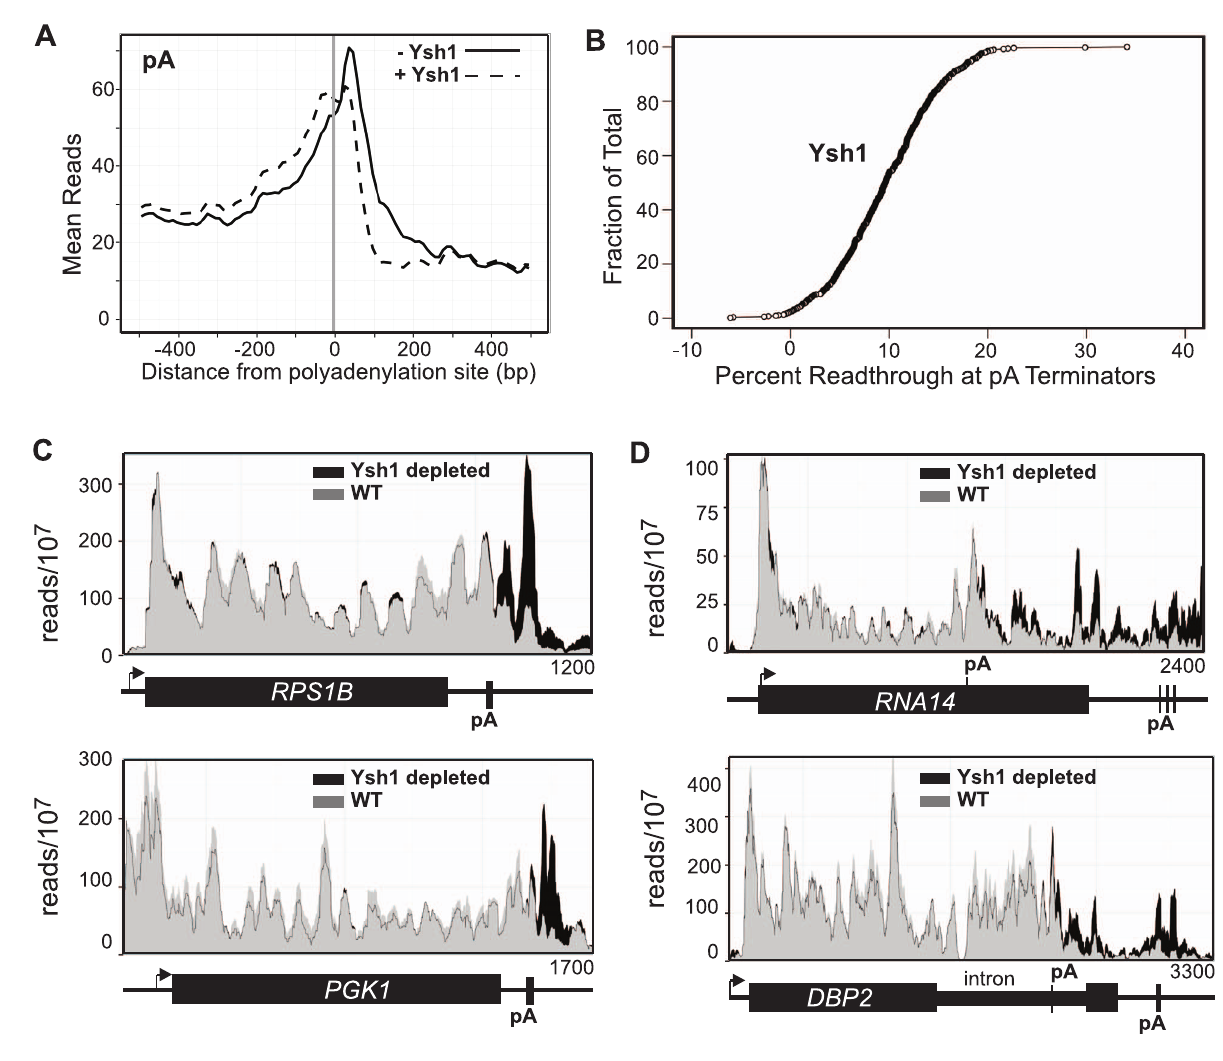
Figure 2. Ysh1 depletion causes readthrough at pA sites. A. Mean reads every 10 bp for the 500 most frequently used pA sites with (dotted) and without (solid) Ysh1. B. Plot showing percent readthrough of each of 500 pA terminators as a fraction of the total 500 pA terminators. C and D. Histograms representing normalized reads with Ysh1 (grey) and without Ysh1 (black) at the given genomic locations. The TSS with the direction of transcription is indicated by an arrow. Genes and pA sites are represented below each graph and the length of the genome depicted is given in the lower right hand corner.